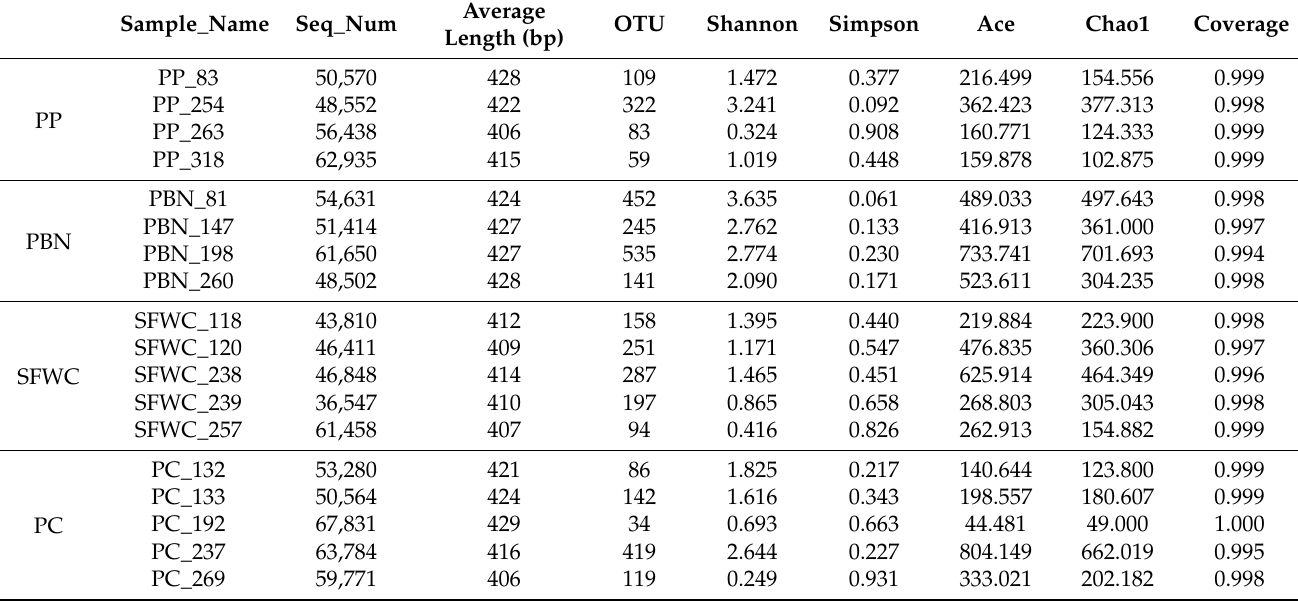
Table 1. Sequence information and diversity values of four traditional fermented vegetables in north